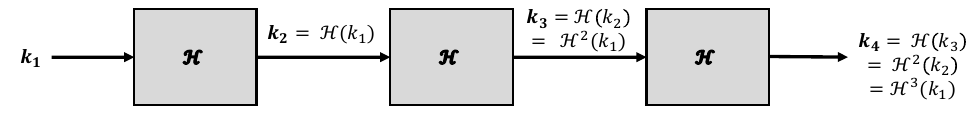
Figure 2. Sample 4-key hash